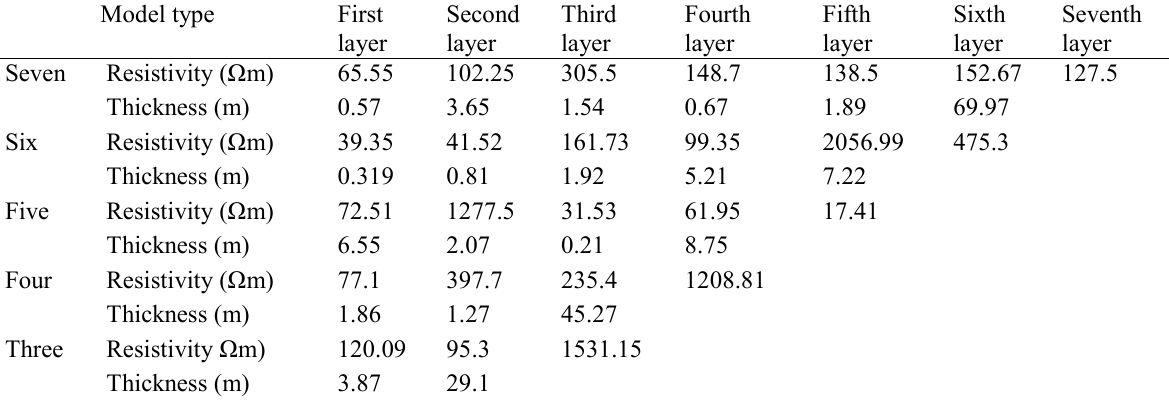
Groups of electro-stratigraphic earth model obtained from the resistivity